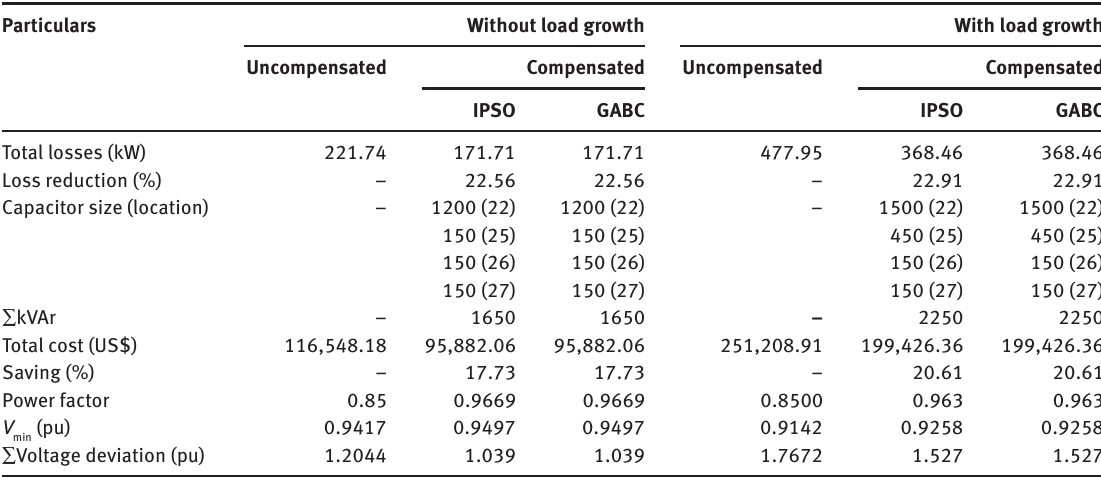
Table 6: Simulation Results of the 34-Bus Distribution Network after SC Placement Using the PLI Approach. Particulars